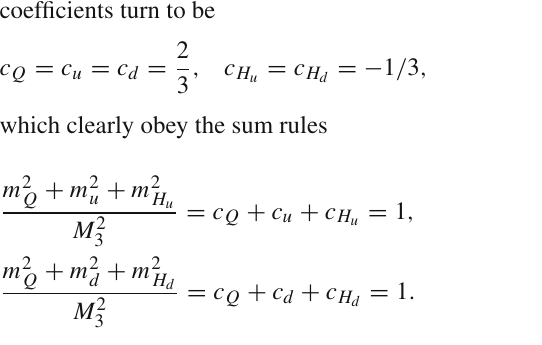
coefficients turn to